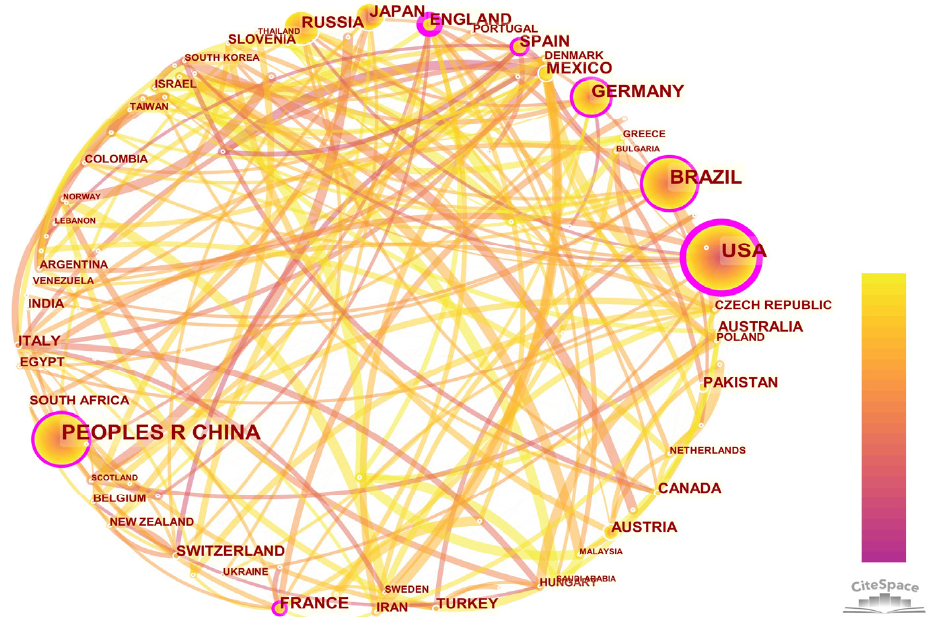
Figure 6. Country collaboration network. The node size represents the country’s publication frequency, and the connection line between nodes represents cooperation. High-centrality nodes are marked by a purple circle, which means the country has facilitated communication with other countries. Table 5. Top 10 countries based on cited frequency.